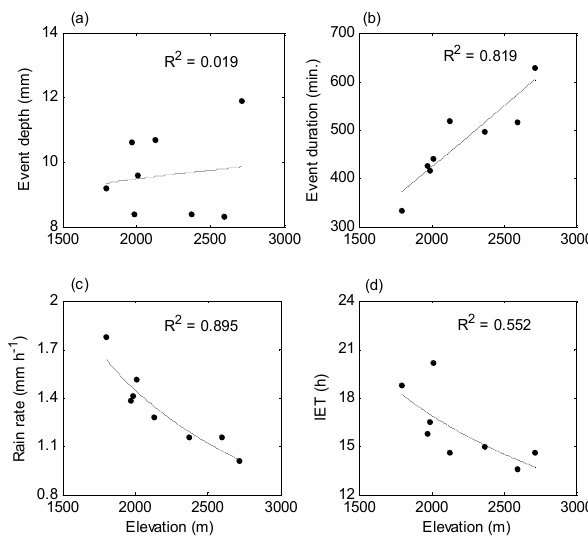
Fig. 8 Relation between event properties and terrain elevation (MIT=8h). The median 770 Fig. 8. Relation between event properties and terrain elevation of each of the event properties is selected for the regression and the regression 771 (MIT=8h). The median of each of the event properties is selected equations are presented in Table 5. 772 for the regression and the regression equations are presented in Ta- 773 ble 5.